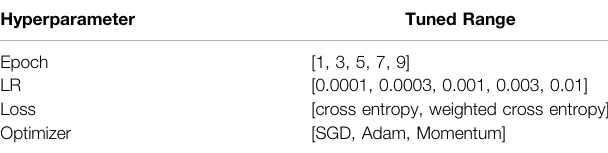
TABLE 6 | BERT performance.